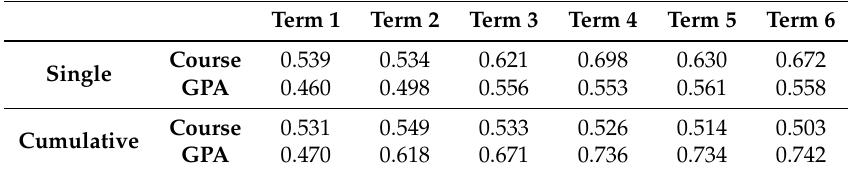
Table 5. Results of the Naive Models.